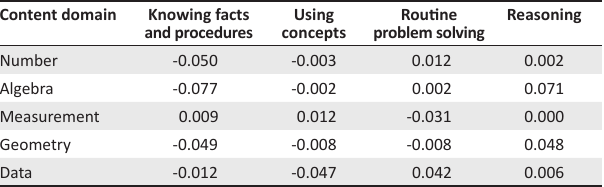
TABLE 9 : Raw cell-by-cell differences between the RNCS assessment standards and the TIMSS 2003 assessment objectives.